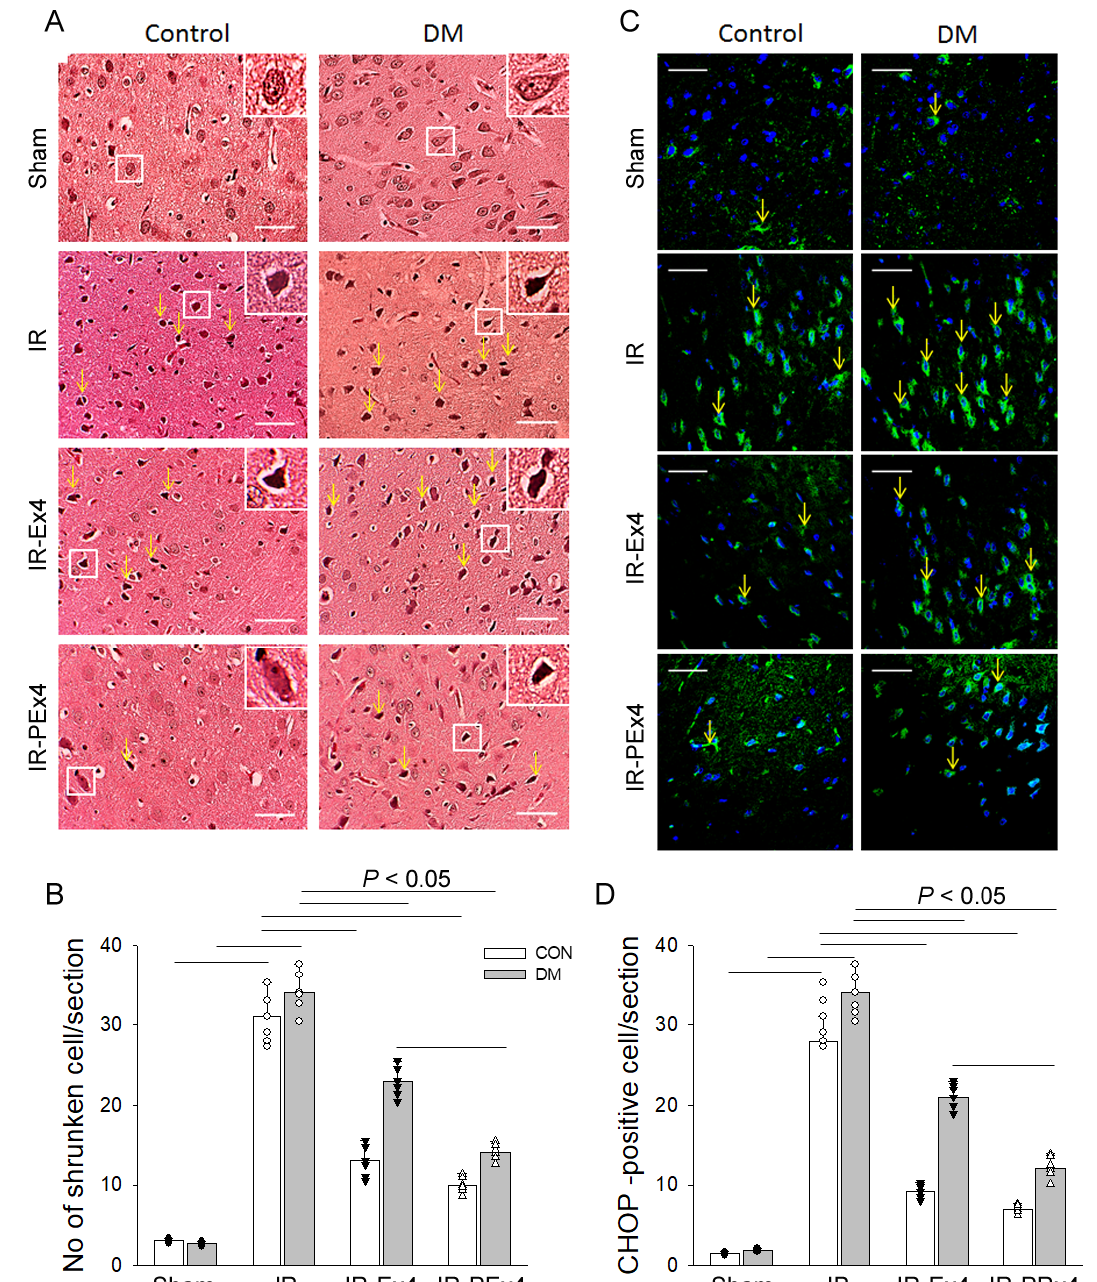
Figure 4. Effect of Ex-4 and PEx-4 on the level of morphological change of prefrontal cortex ( A ) with shrunken morphology indicated by yellow arrows with hematoxylin–eosin stain and CHOP-positive stain (( C ), green fluorescence indicated by yellow arrows) in rat brain sections of control and DM rats. The number of shrunken neurons is significantly increased after IR injury and decreased in the treatment of Ex-4 (IR-Ex4) or PEx-4 (IR-PEx4) in brain sections ( B ). The number of CHOP-positive cells after IR is significantly increased and decreased in treatment of Ex-4 (IR-Ex4) or PEx-4 (IR-PEx4) in brain sections ( D ). (scale bar = 50 µm). Data are expressed as mean ± SEM in each group ( n = 6) using the single values. The statistical difference is indicated by the horizontal line with p < 0.05 between groups using one-way ANOVA, followed by Bonferroni’s post hoc test. Each symbol represents one sample in different groups.